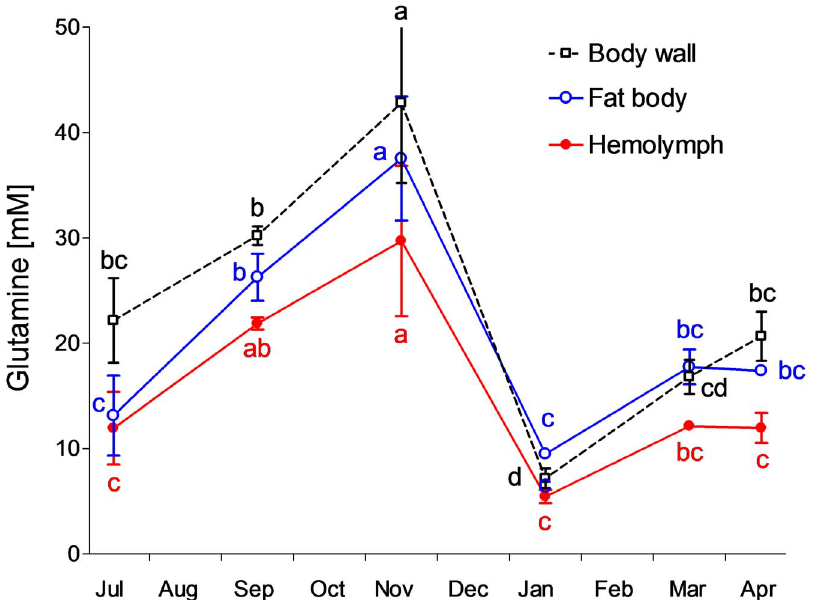
Figure 4. Glutamine. Seasonal whole-body and tissues changes of glutamine concentrations in field-sampled caterpillars of Cydia pomonella during 2010/2011. Each point is the mean 6 S.D. ( n =3 replicates, 3 individuals each). Influence of sampling date on glutamine concentration was tested by ANOVA followed by Bonferroni’s post hoc test (means flanked with different letters are significantly different).